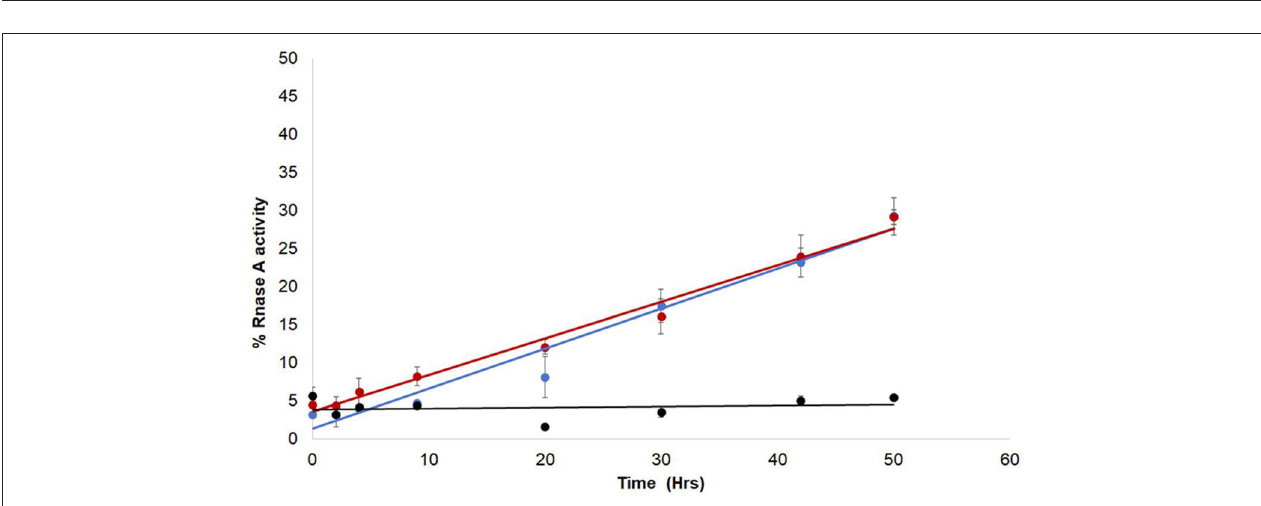
FIGURE 3 | The Cys-deficient mutant form of ZnJ2 is capable of oxidative refolding of reduced and denatured RNaseA. RNaseA was reduced and denatured as described in Figure 2 . Refolding of the reduced and denatured RNaseA was initiated by its dilution (200-fold) into renaturation buffer to a final concentration of 50 µ g/mL. Refolding was either spontaneous ( • ) or conducted in the presence of 10 µ M WT ZnJ2 ( • ), or 10 µ M ZnJ2 Cys- > Ser mutant ( • ). Aliquots were removed at various intervals and transferred into the assay mixture. RNaseA activity was measured by monitoring the hydrolysis of cytidine 2 ′ :3 ′ -cyclic monophosphate at 284nm. The percentage of refolding was calculated relative to native RNaseA activity. Similar results were obtained in three independent replicate